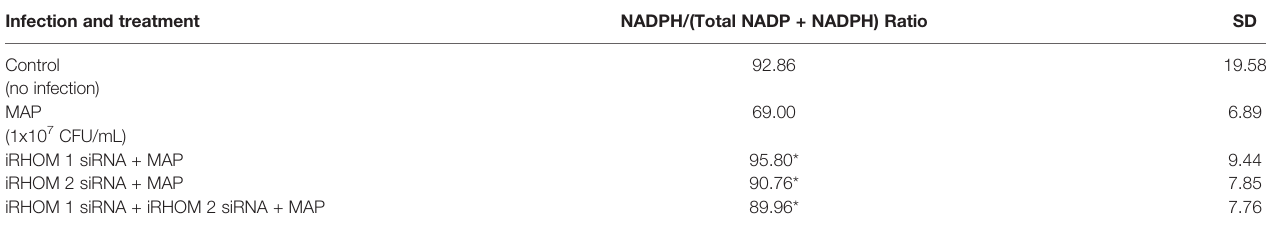
*Indicates P-value of less than